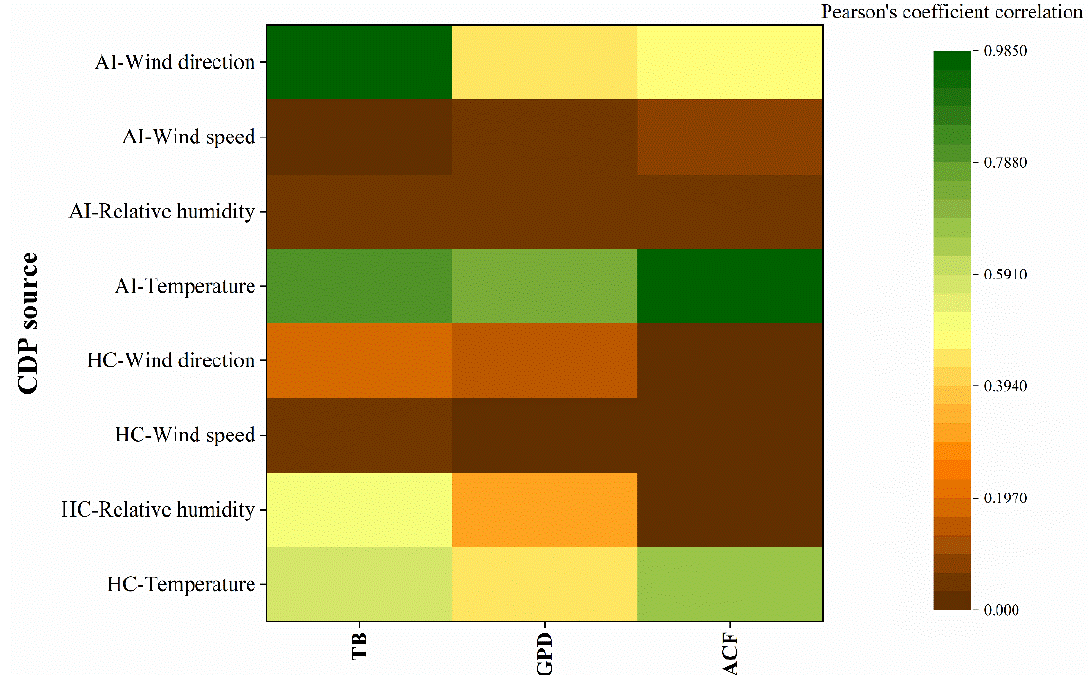
Figure 9. Heat map of Pearson’s coefficient correlation among cumulative drift percentages (respec- tively, test bench, ground petri dish, and airborne collection frame) and meteorology characteristics (temperature, relative humidity, wind speed, and wind direction). Table 6. Correlation among CDP values obtained from different collectors (respectively, test bench, ground petri dish, and airborne collection frame) for the HC and AI